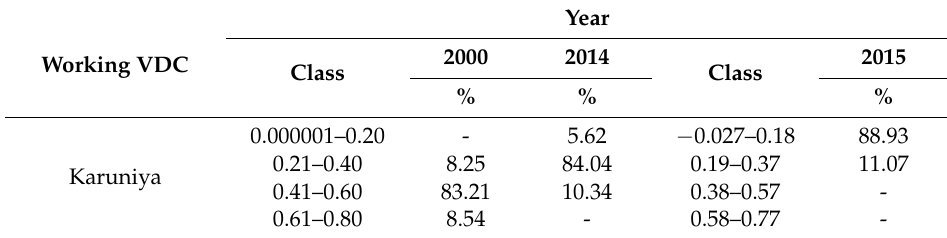
Figure 6. Soil moisture index of Karuniya VDC for different years: ( a ) 2000; ( b ) 2014; and ( c ) 2015. Table 7. Soil moisture index (SMI) for the different years in Karuniya VDC.